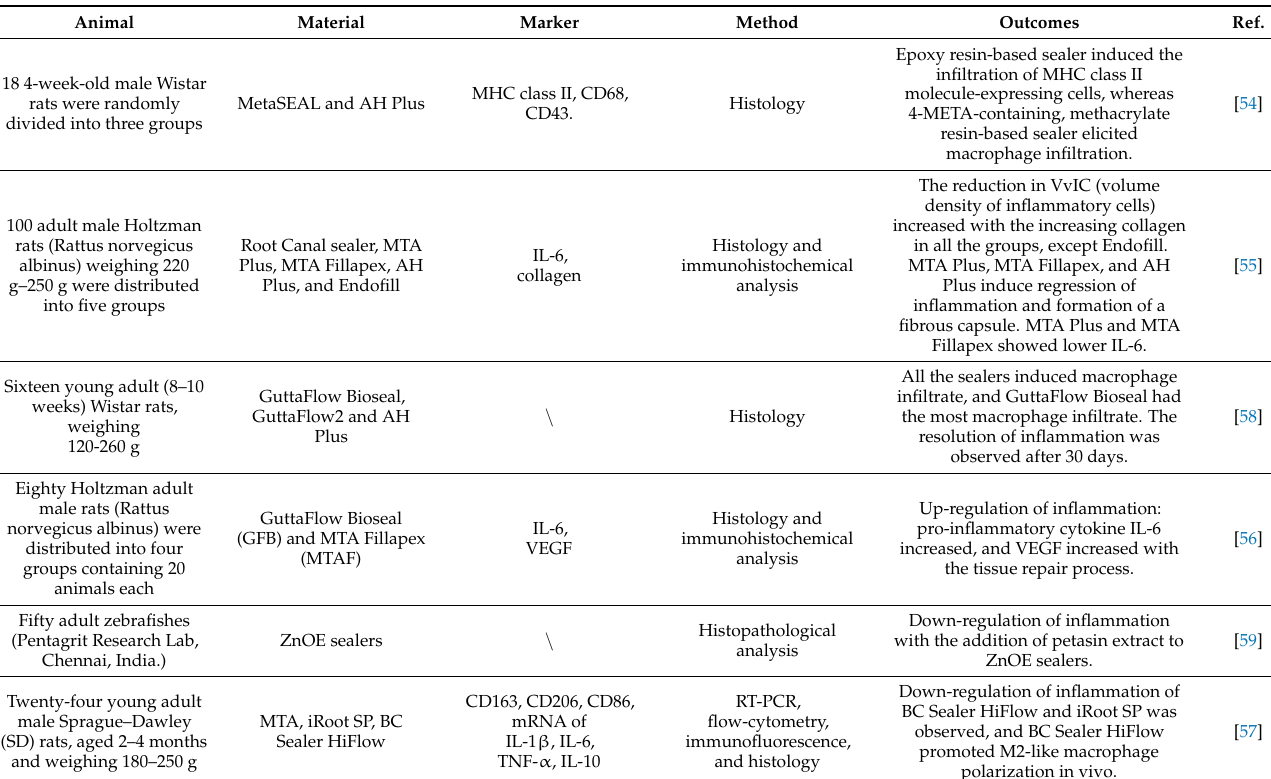
Table 2. Summary of immunomodulatory effect of endodontic sealers in vivo studies. “Yes” repre- sented a low risk of bias, “No” represented a high risk of bias, and “Not” represented an uncertain risk. Furthermore, “Overall” indicated the percentage of low risk of bias in each study.